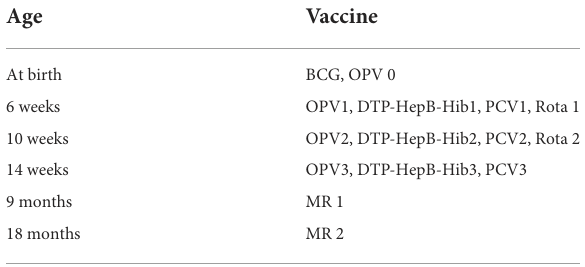
TABLE 1 Immunization schedule for under-five children in Tanzania (Adapted from the Expanded Program of Immunization (EPI), Tanzania)